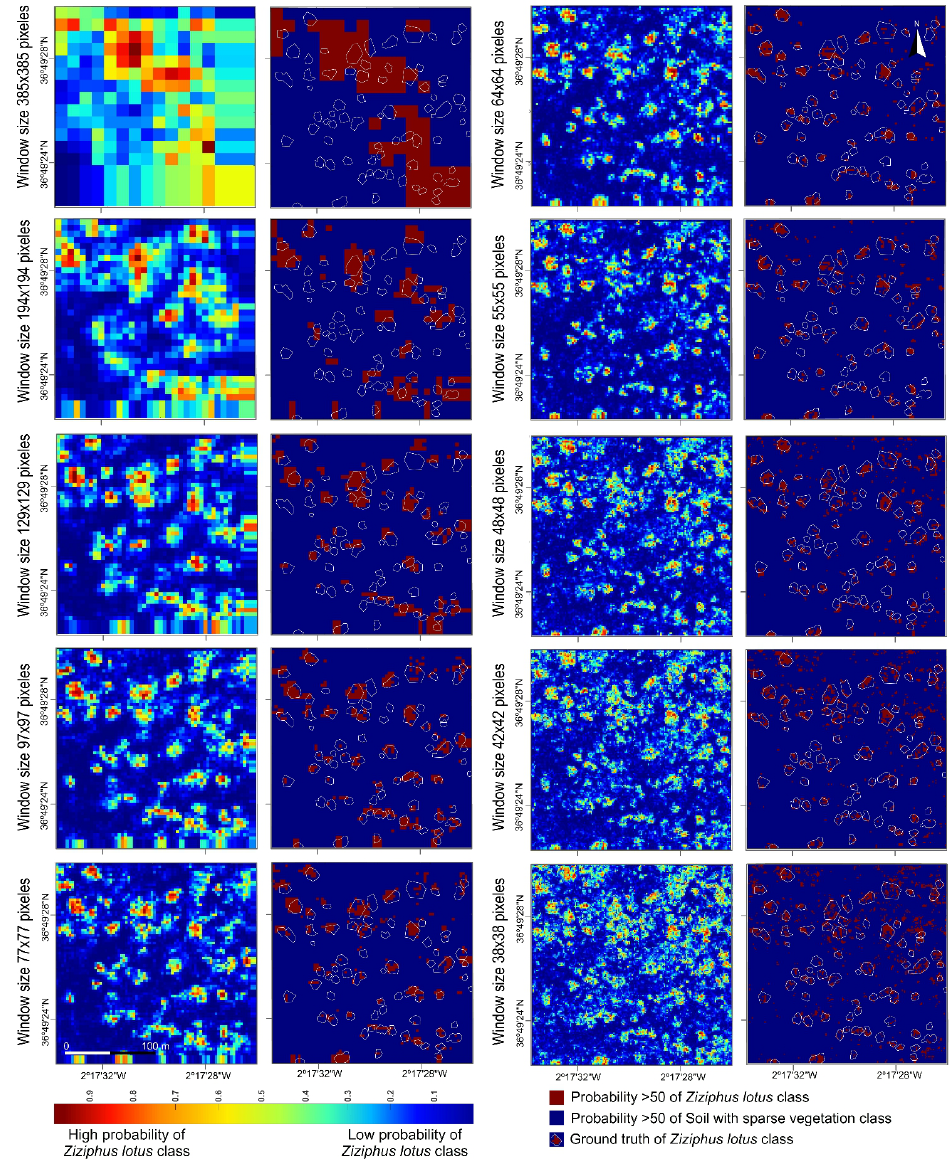
Figure 4. Maps showing the probability of Ziziphus lotus presence according to the CNN-classifier trained with fine-tuning and data-augmentation and applied on different sliding-window sizes from 38 × 38 to 385 × 385 pixels in Test-zone-1. The first and third columns show the heatmaps of the probability of Ziziphus lotus presence, and the second and fourth columns show the corresponding binary maps after applying a threshold of probability greater than 50%. The white polygons correspond to the ground-truth perimeter of each individual georeferenced in the field with a differential